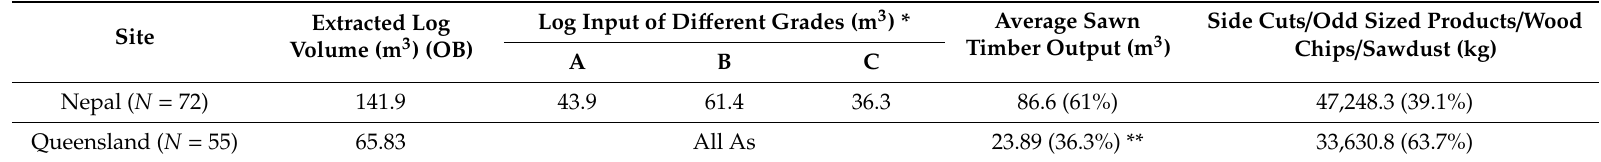
Table 4. Sawn wood recovery from the extracted logs in Nepal and Queensland